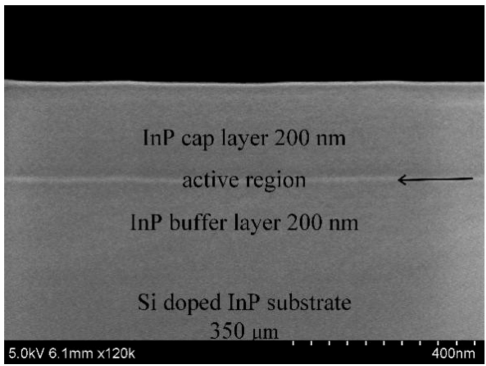
Figure 1. Cross-section scanning electron microscope (SEM) image of Al 0.07 Ga 0.22 In 0.71 As quantum well (QW), as